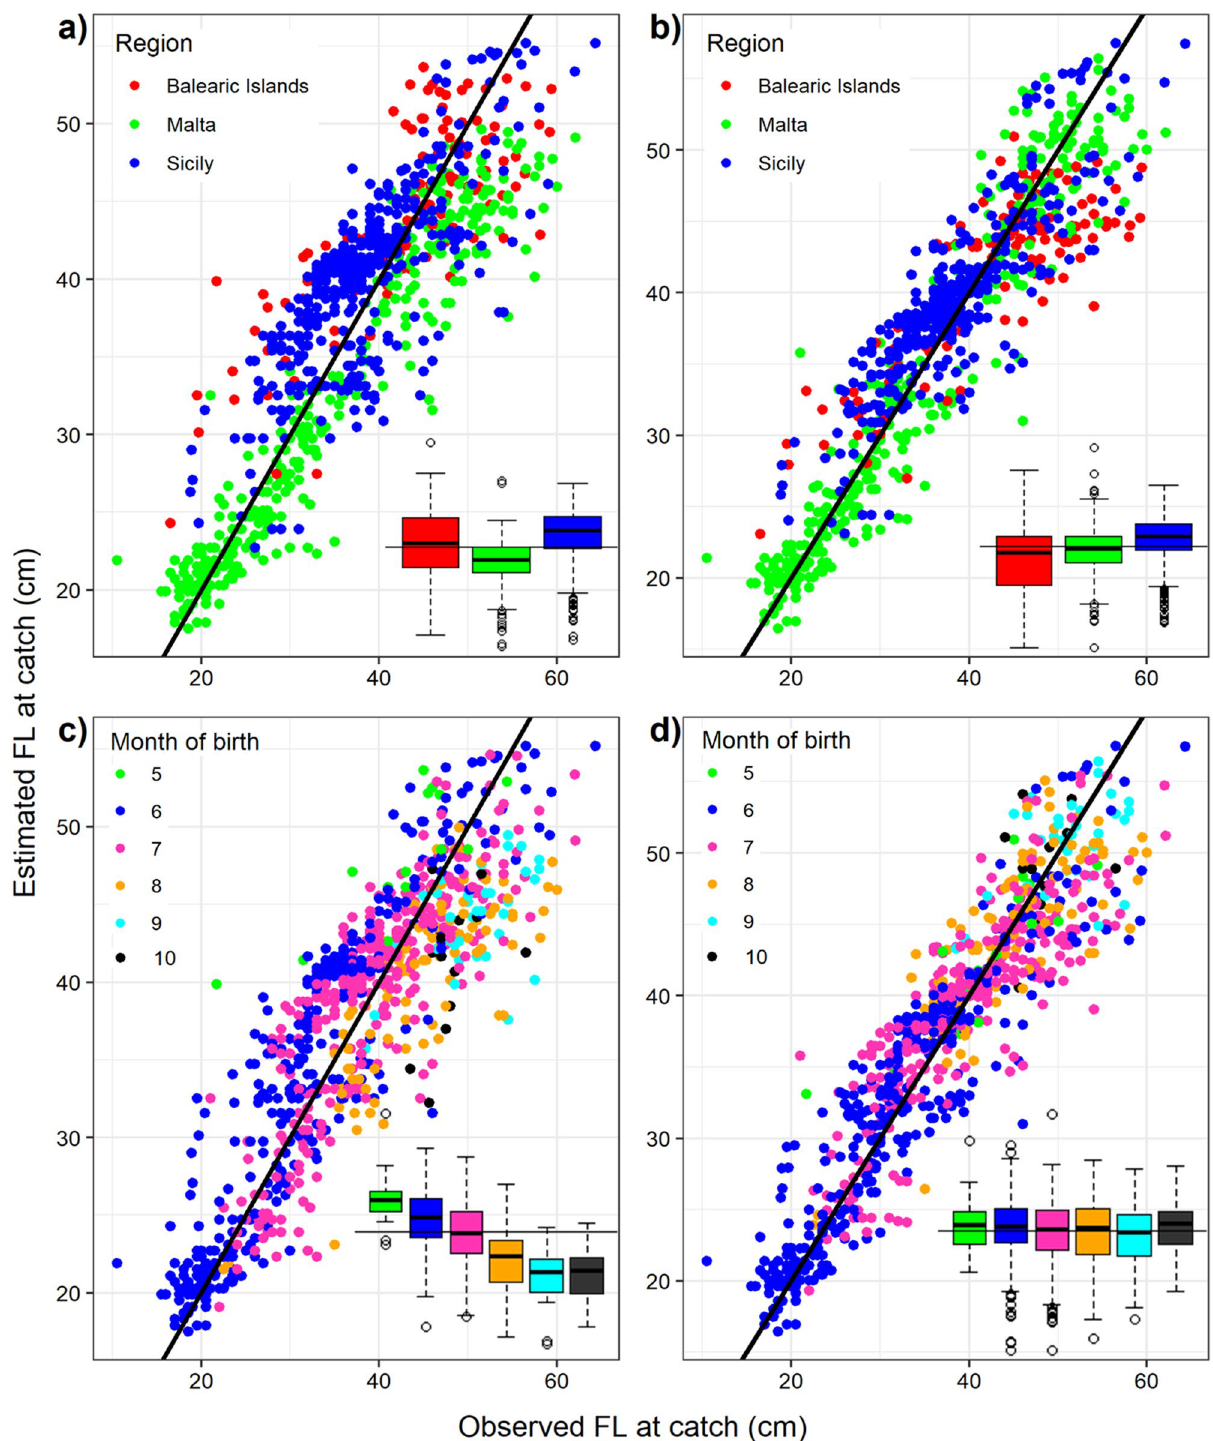
Figure 3. Estimated vs. observed fish length (furcal length, FL) at capture of the 876 individuals used for model validation. Two versions of the model are represented. A first version (panels a , c ) corresponds to the environmental-independent model (not accounting for temperature and photoperiod at birth). A second version (panels b,d ) corresponds to the environmental-dependent model with the best DIC. The boxplots in each panel show the residuals’ distribution by region ( a , b ) and month of birth ( c , d ). The environmental- dependent model version largely corrects the biases, which can be seen as a better horizontal alignment of the boxplots, therefore not over or underestimating the length at catch. Graph created with R 3.6.2 (https:// www.r- proje ct. org/) 24 using the ggplot2 package 25